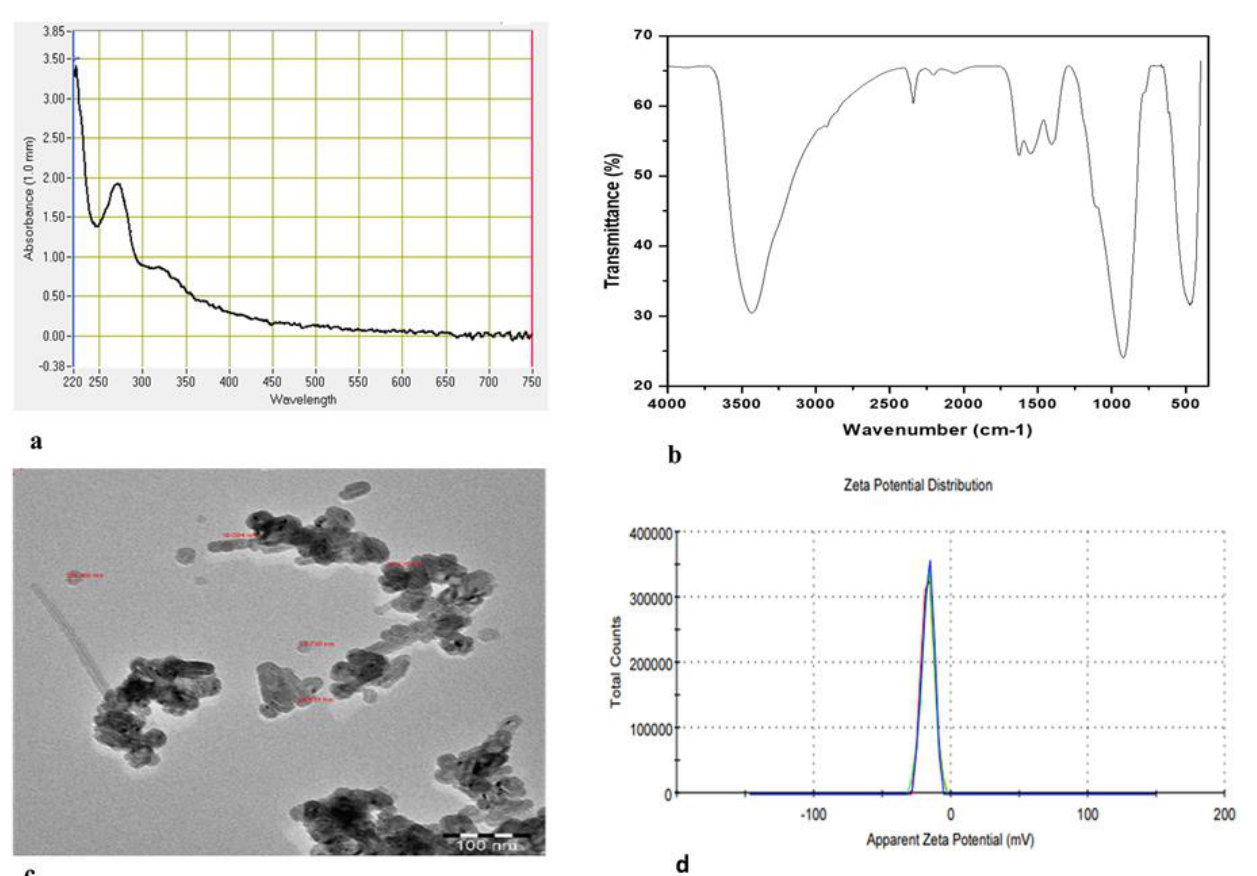
Figure 2. Biosynthesis of ZnO-NPs using the aqueous leaf extract of Heliotropium bacciferum : ( a ) H . bacciferum in natural habitat; ( b ) aqueous leaf extract; ( c ) synthesized ZnO-NPs; ( d ) ZnO-NPs in pelleted form with secondary metabolites; ( e ) powder form of synthesized ZnO-NPs .